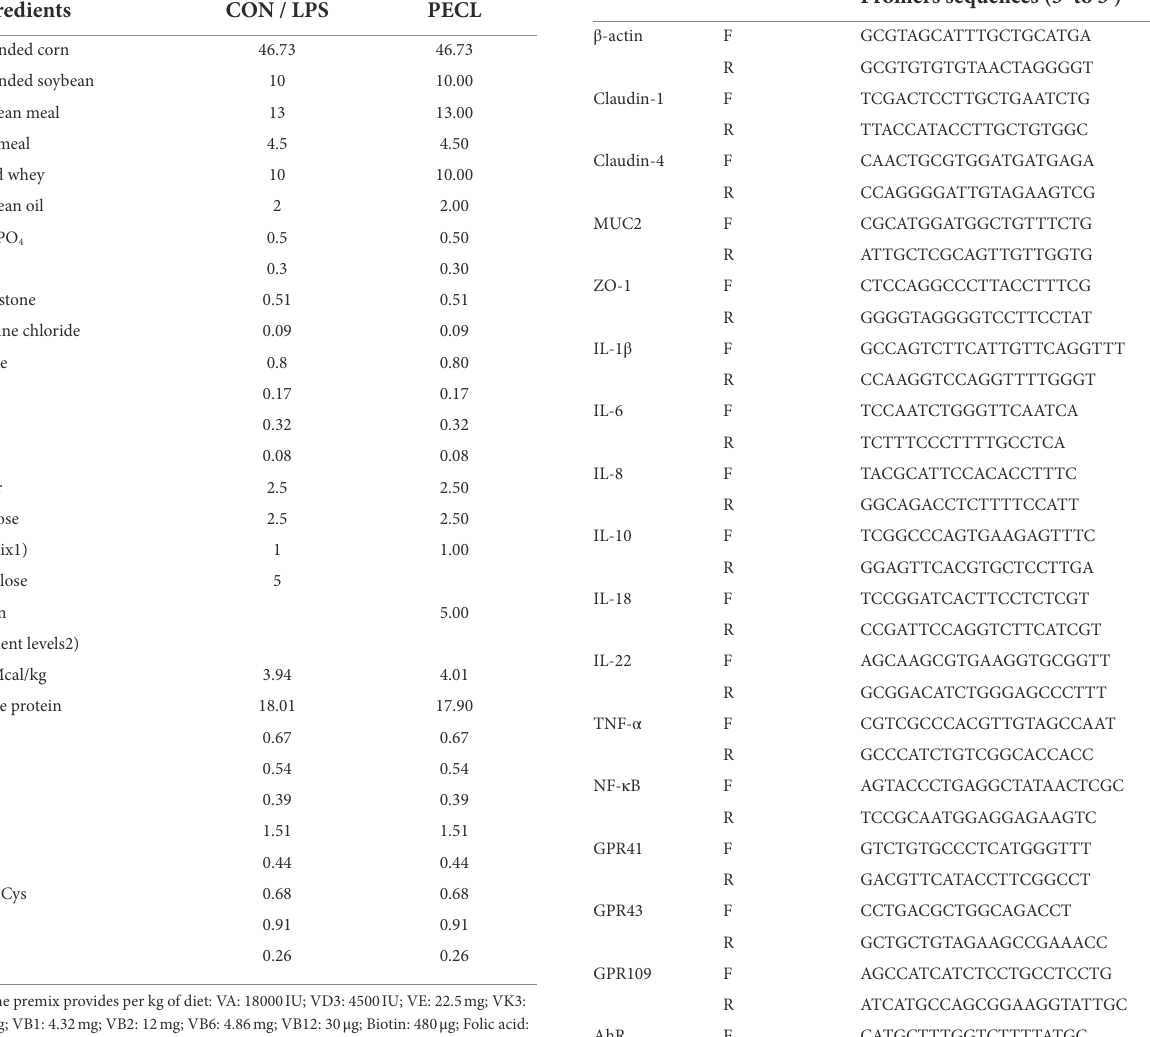
TABLE 1 The composition and nutrient content of basal diets (air-dry basis) %.